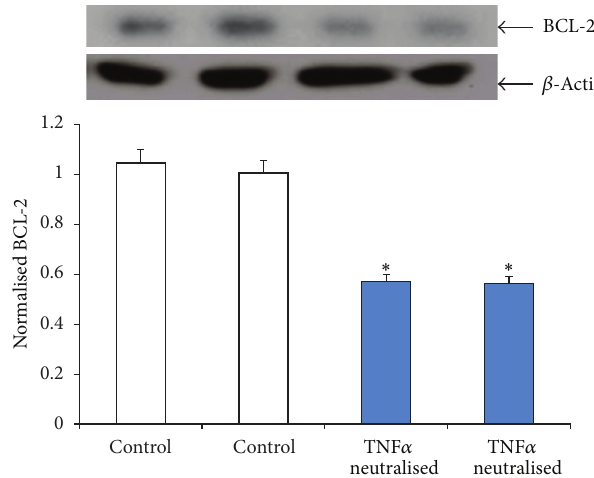
Figure 6: Effects of anti-TNF 𝛼 neutralized conditioned media on the expression of anti-apoptotic BCL-2 in EGE cells. Conditioned media collected from SW872 cells grown to more than 80 percent confluence were centrifuged, filtered, diluted to 1%, and neutralized for an hour with 1ng/mL of anti-TNF 𝛼 antibody for an hour at 37 ∘ C. Lysates prepared from control and treated EGE cells were analyzed by Western blotting with anti-BCL-2 antibody. The intensity of each protein signal was quantified and normalized with corresponding 𝛽 -actin. ∗ 𝑃 < 0.05 compared with control (mean ± SE; 𝑛 = 3